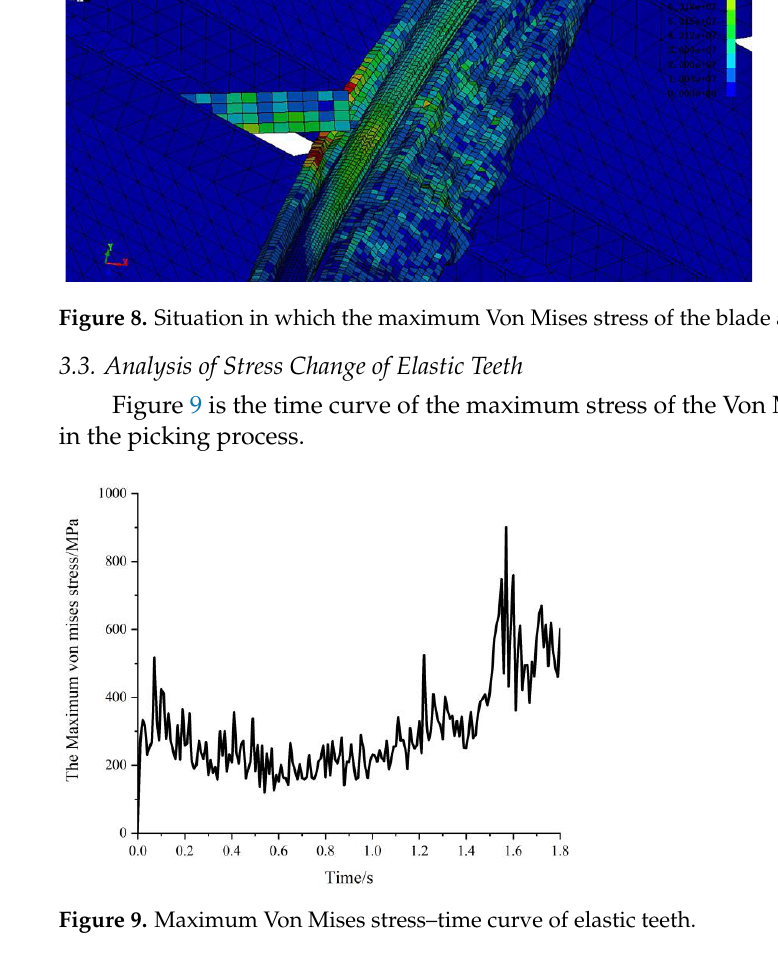
Figure 7. Curve of the maximum Von Mises stress of blade and vein.